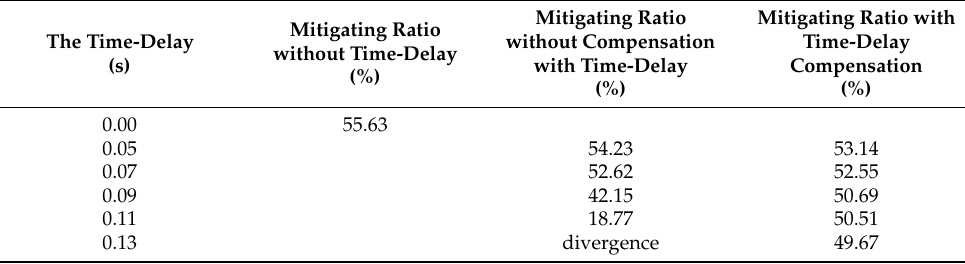
Figure 12. The experimental displacements at mid-span with 0.11 s time - delay under random ex- citation. Table 7. Experimental response reductions at mid-span under random excitation. The Time-Delay (s) Mitigating Ratio without Time-Delay (%)